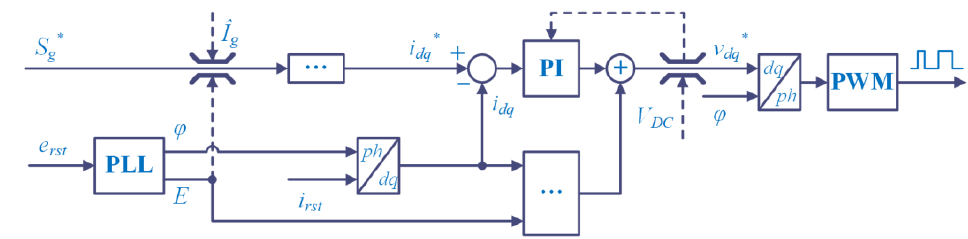
Figure 8. Grid-tie converter control system overview.